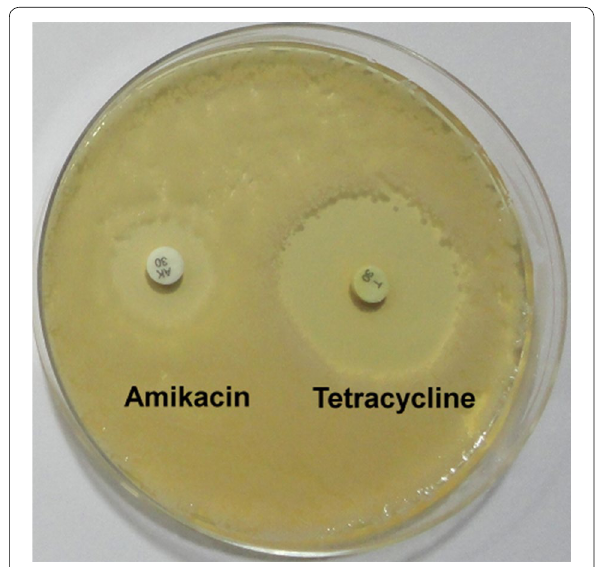
Fig. 3 Bacterial culture plate of AJK3 strain showing the inhibition zones around the discs loaded with 30 µg of antibiotics